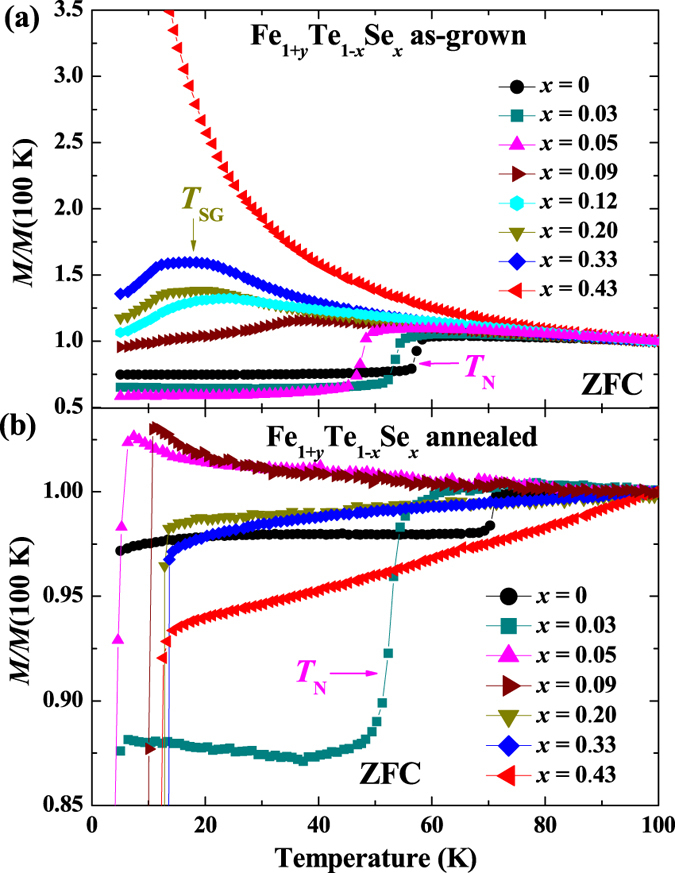
Magnetic susceptibilities measured at 10 kOe with H || c for Fe1+yTe1−xSex (0 ≤ x ≤ 0.43) (a) before and (b) after O2-annealing.